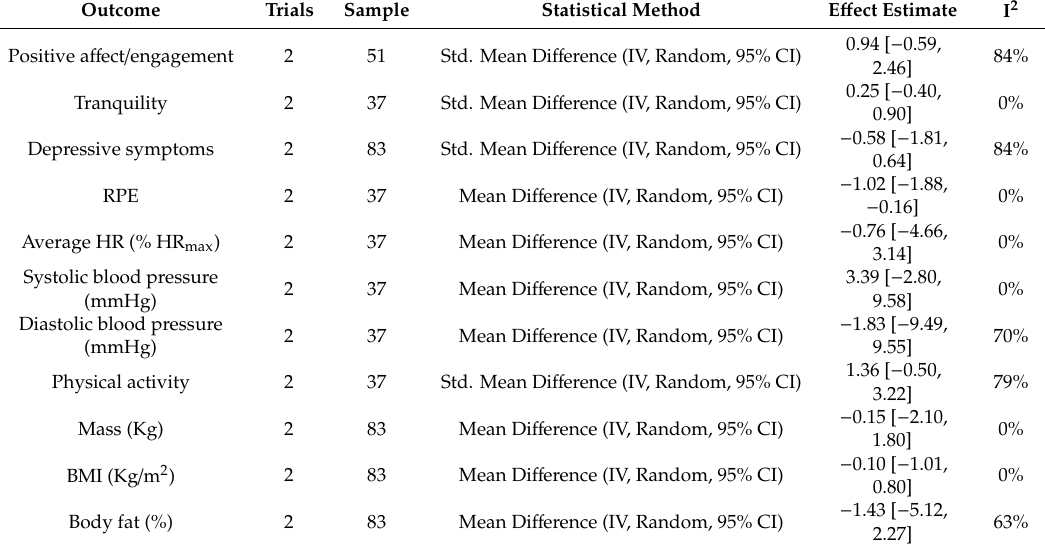
Table 3. The longitudinal e ff ects of outdoor green exercise versus indoor exercise on emotions and enjoyment: meta-analysis of parallel